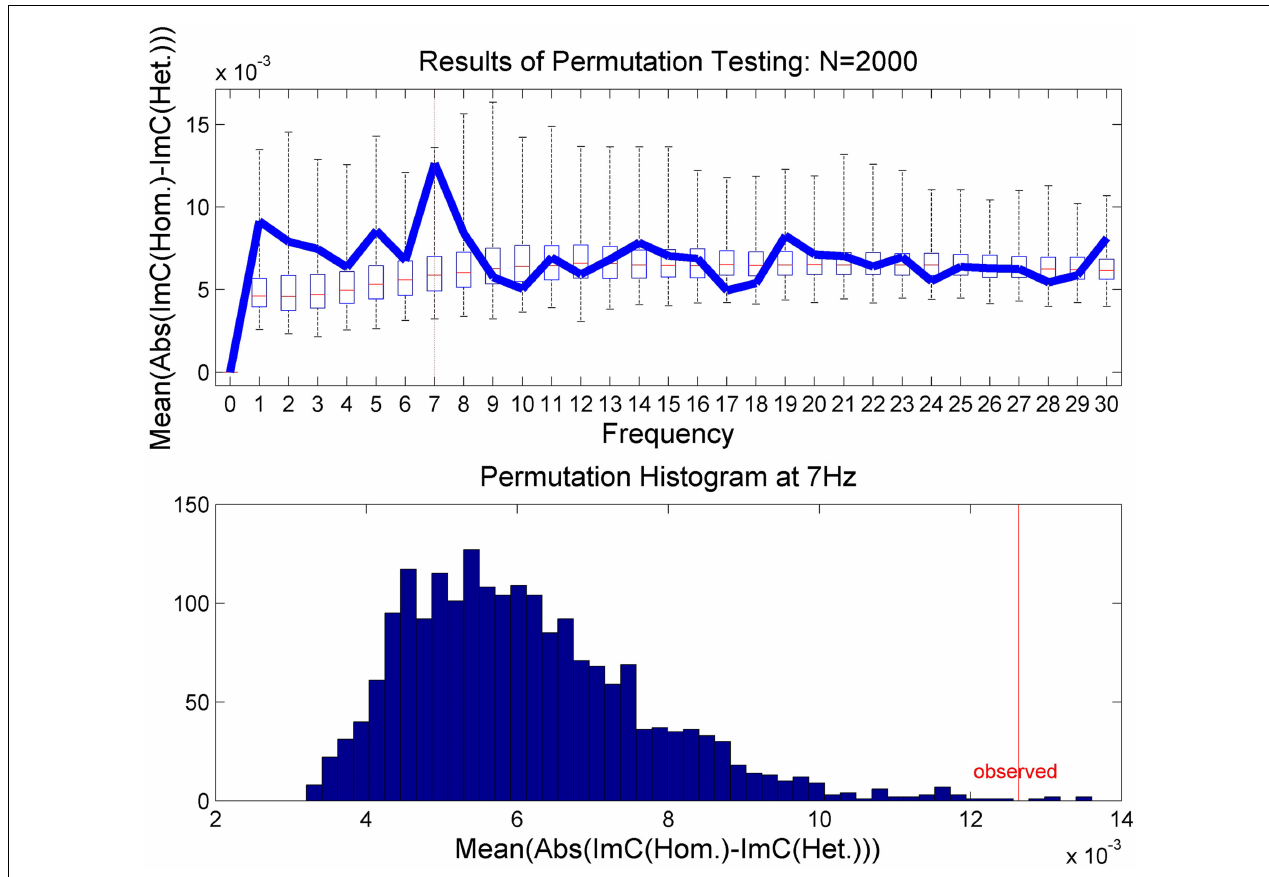
results outside of the quartiles.The results of the true class memberships are displayed in blue.The lower plot shows histogram of the permutation results for 7Hz